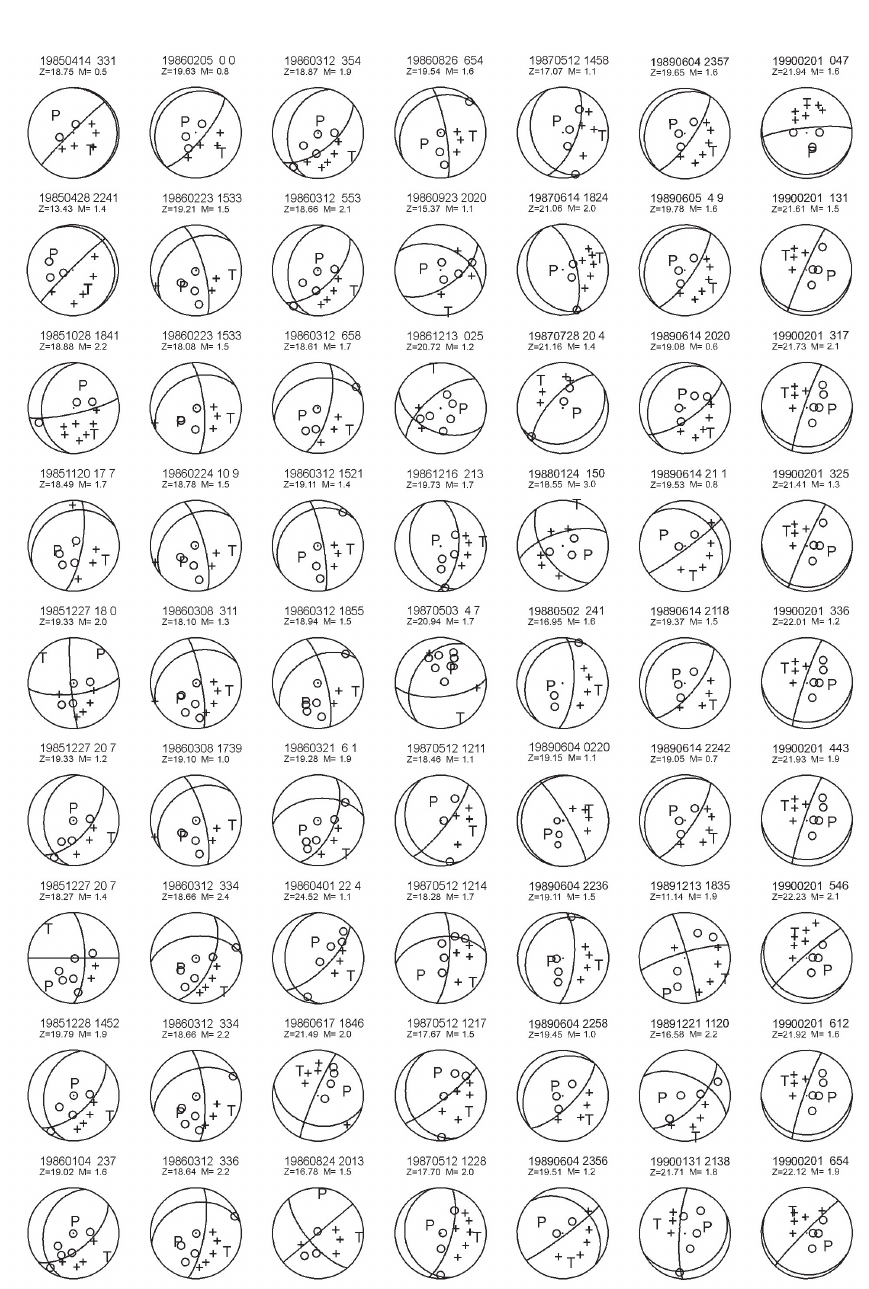
Fig. 2. Fault plane solutions (lower hemisphere equal-area projection) of the 120 best constrained events. For each mechanism the date (year, month, day), the origin time (hour, minute), the focal depth in km (z) and the magnitude (M L ) are reported. P and T denote the P- and T-axes position. Open circles and crosses indicate dila- tations and compressions,